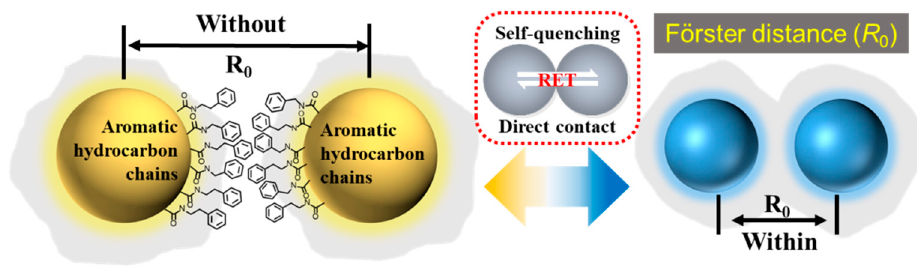
Figure 7. Schematic diagram of the solid-state fluorescence mechanism of CDs.